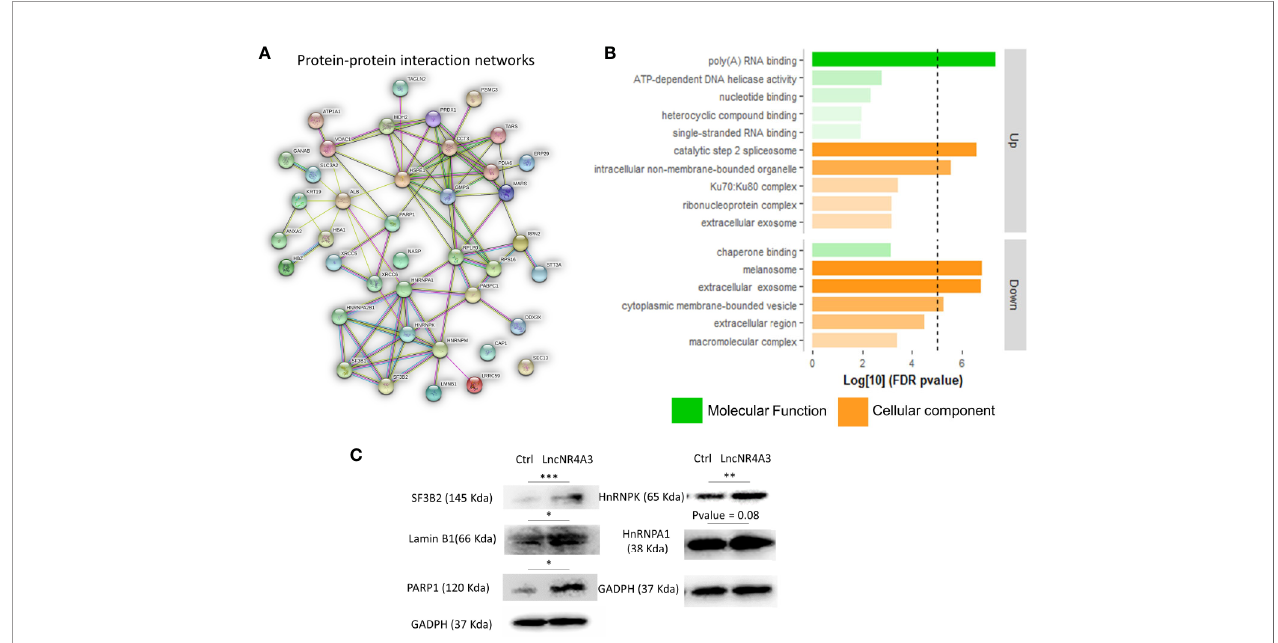
FIGURE 2 | (A) Protein – protein interaction network, a weighted linkage graph constructed using STRING software, inputting the differentially expressed proteins identi fi ed in the proteomics analysis. (B) Histogram plotting the Log[10] of the p-values obtained from the gene ontology enrichment analysis, cellular component, and molecular function ontology Log[10]p-values were plotted for up-regulated and down-regulated proteins obtained from proteomics analysis, threshold of 5 is denoted by the dashed line. (C) Immunoblots con fi rming regulation of several target proteins identi fi ed by the MS-proteomics analysis in K-562 controls and lncNR4A3 over-expressing cells, blots from three independent experiments shown in Supplementary Figure 10 , paired t-test was applied to stablish signi fi cant differences between optical density of the blots (*: <0.05, **: <0.01,